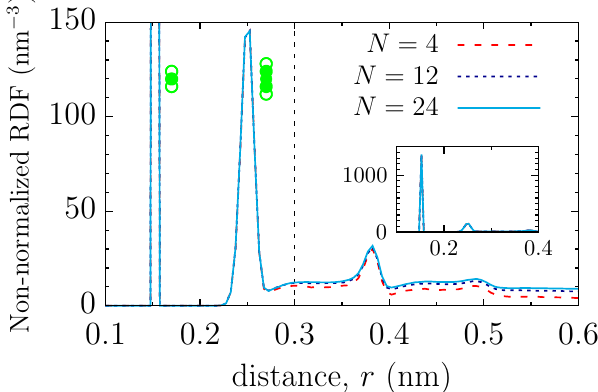
Figure 2. Structural properties of polymer coating. Non-normalized radial distribution function (RDF) is shown for a few polymers of different length N . The inset demonstrates a delta-like peak at r = 0.15 nm, arising due to the two next-neighboring beads, as depicted in the sketch. The thin vertical line at r 0 = 0.3 nm separates the short and long distance regimes, where the effect of polymer length is negligible and appreciable, respectively. The empty circles in the sketches show the beads of a polymer that contribute the most to the corresponding